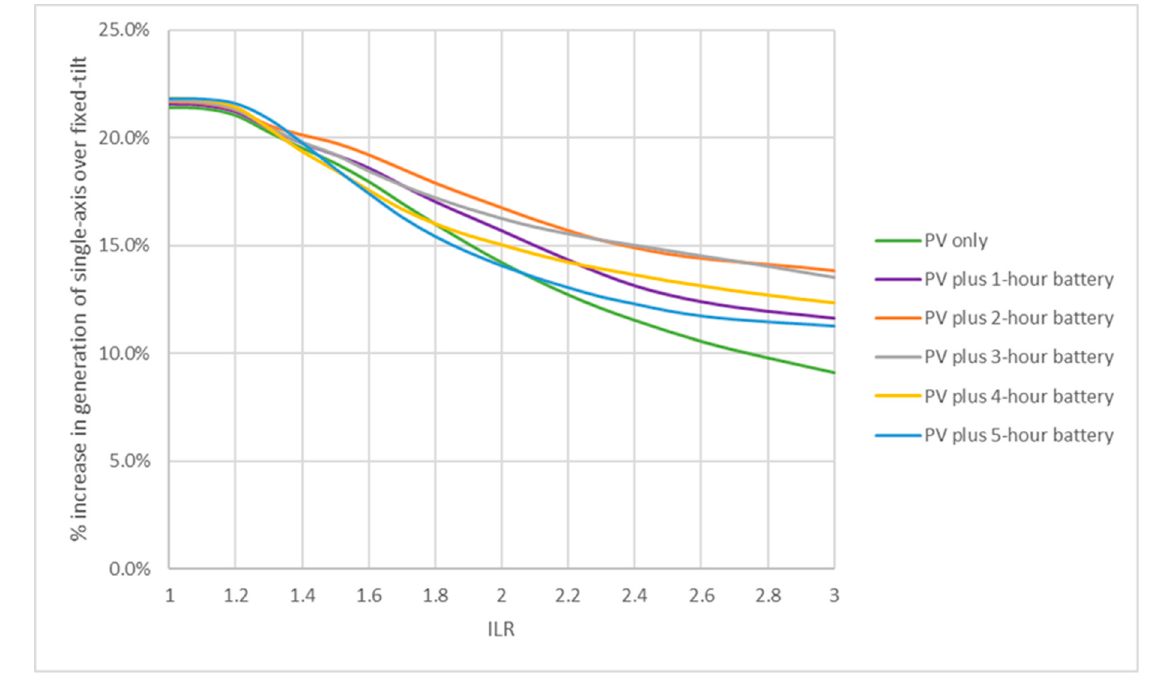
Figure 10. Percentage increase in generation of single over fixed tilt.